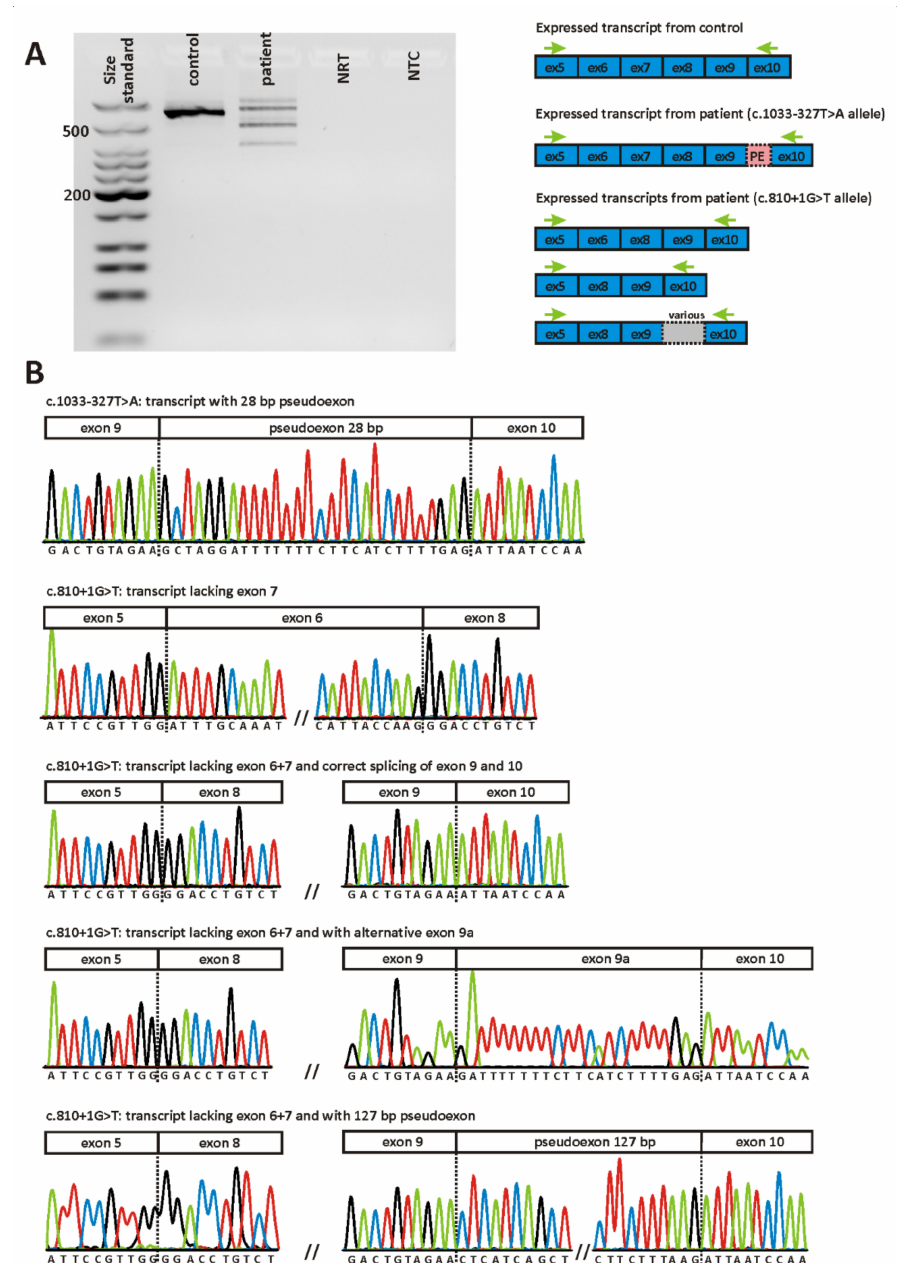
Figure 6. Direct transcript analysis in patient MDS438 from blood. ( A ) Agarose gel electrophoresis of RT-PCR products. Gel loading is as follows: A size standard (low molecular weight DNA ladder, NEB) is loaded in the leftmost lane. RT-PCR products derived from a healthy control person are shown in lane 2, while those from the patient are shown in lane 3. NRT (lane 4), no reverse transcriptase control; NTC (lane 5), no template control. Schemes of the amplified products are presented next to the agarose gel picture. ( B ) Sequencing of patient ´ s RT-PCR products following subcloning. Only relevant junctions are shown. Three major transcripts could be identified: Transcripts expressed by the c.1033-327T>A allele with a pseudoexon of 28 bp spliced between exon 9 and exon 10 and transcripts expressed by the c.810+1G>T allele lacking either exon 7 or both exon 6 and 7. In addition, some transcripts lacking both exon 6 and 7 showed additional aberrant splicing between exon 9 and 10: inclusion of the 28 bp pseudoexon (not depicted), inclusion of the alternative exon 9a or inclusion of a 127 bp